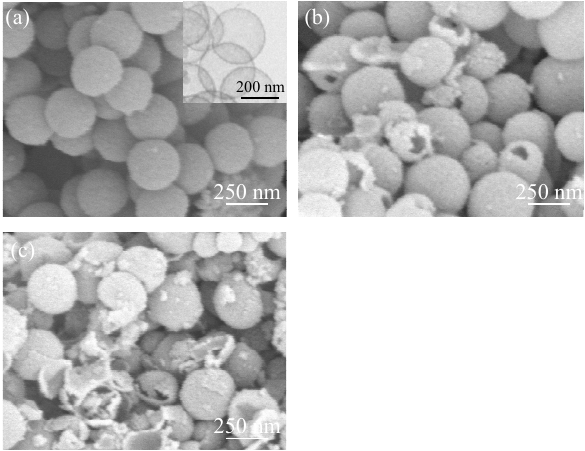
Fig. 3 SEM and TEM images of the silica–alumina composites prepared using (a) 40, (b) 80, and (c) 120 g of the PS